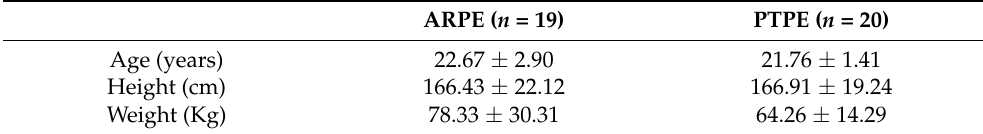
Table 2. General characteristics of participants.